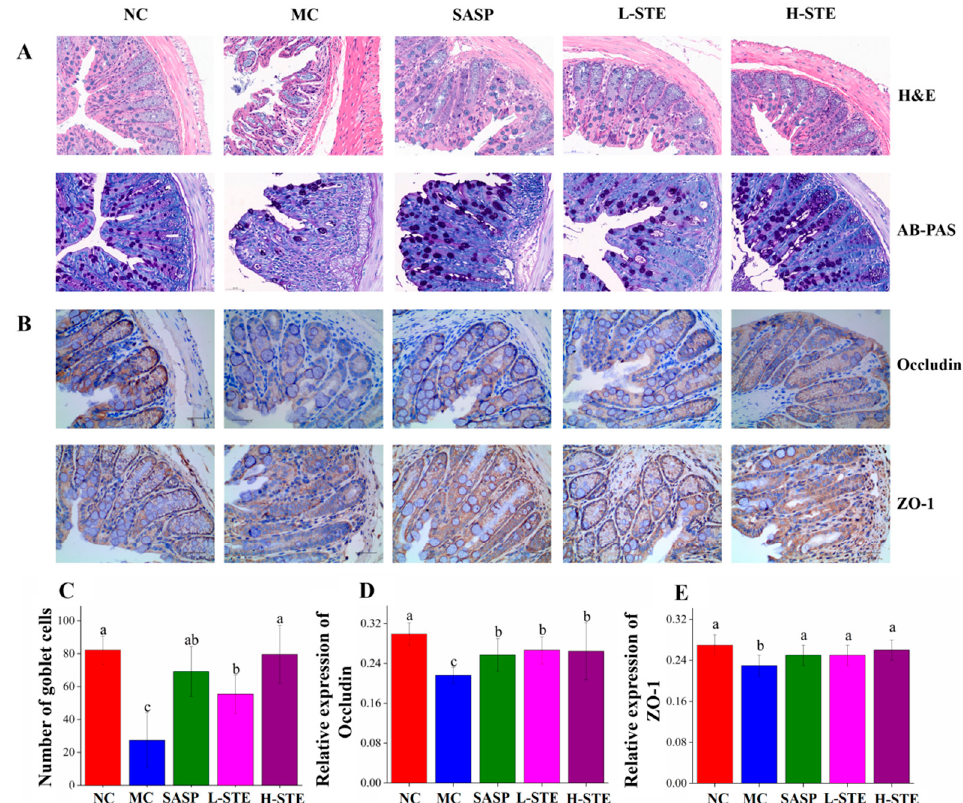
Figure 4. Effects of STE on colonic histopathological changes and tight junction protein expression in DSS-induced ulcerative colitis mice. ( A ) H&E staining and AB-PAS staining analysis of colon tissues (magnification of 400 × ). ( B ) The immunohistochemistry analysis of Occludin and ZO-1 in the colon tissue (magnification of 400×). ( C ) The goblet cell count on AB-PAS staining of colonic tissue. ( D ) The expression of Occludin in the colon. ( E ) The expression of ZO-1 in the colon. Values are expressed as the mean ± the SD ( n = 5). Bars with different lowercase letters represent significant differences ( p < 0.05).